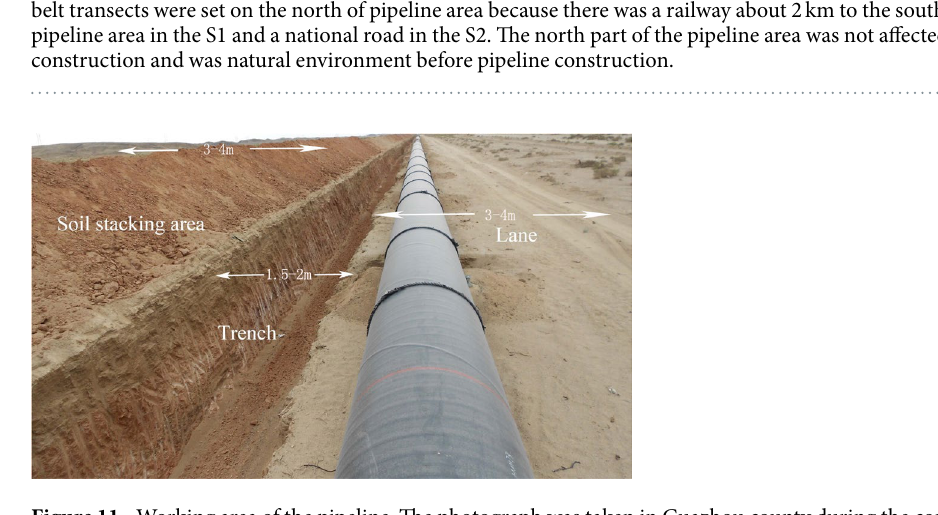
Figure 11. Working area of the pipeline. The photograph was taken in Guazhou county during the construction of WEGP II. When construction was completed, the trench was renamed pipeline area, and soil stacking area began natural recovery. The lane was usually kept and used as a companion road. The trench was about 1.5–2 m wide. The Lane and Soil stacking area were both 3–4 m